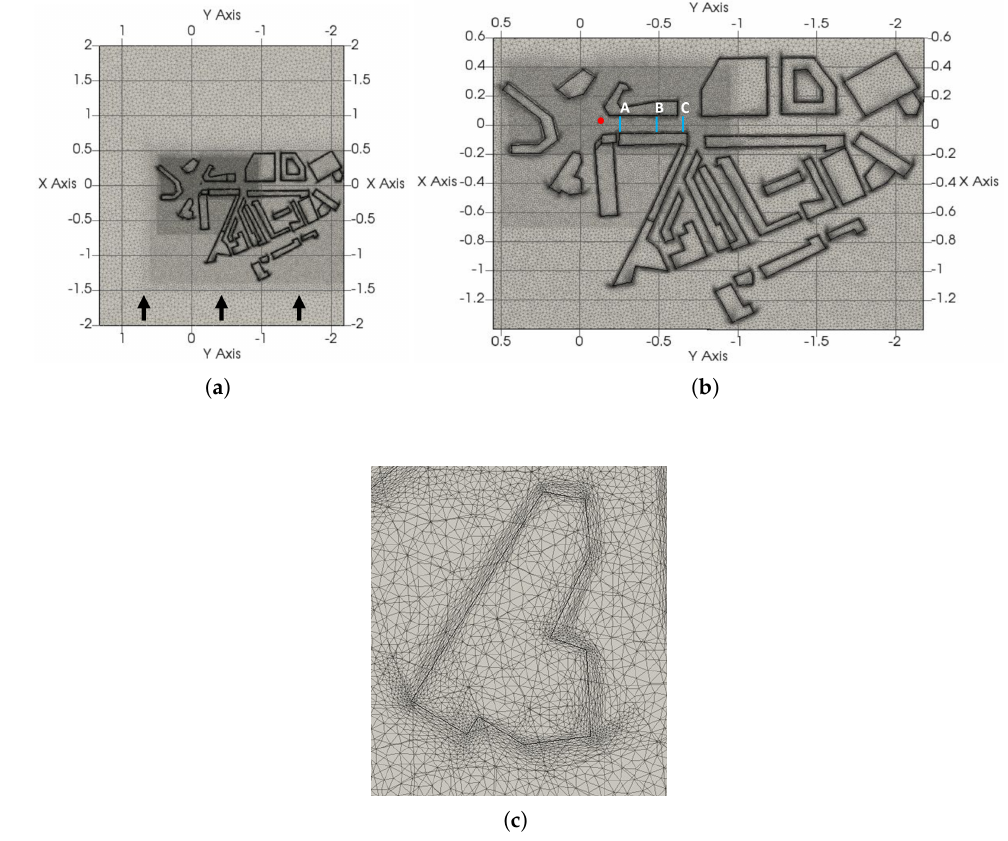
Figure 1. LES mesh configuration for wind tunnel simulation. Dimensions are shown in metres and the domain height was set to the height of the wind tunnel, H = 2m. ( a ) LES mesh for wind tunnel simulation, the full extent of the domain is shown, ( b ) Location of tracer source (red circle) and measurement planes (blue lines), ( c ) Mesh refinement at a building